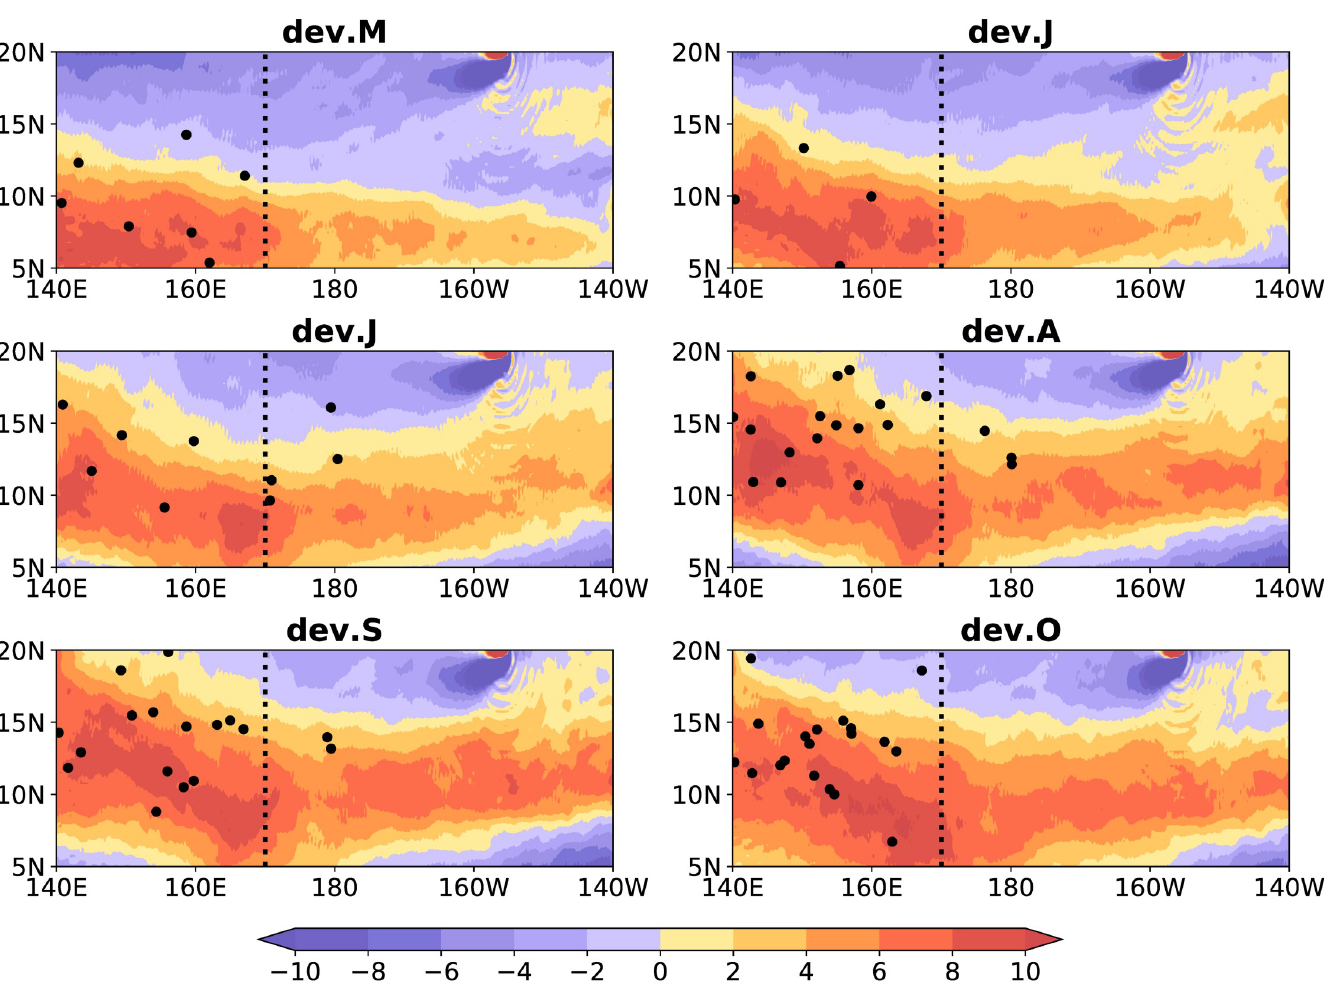
Fig 8. Location of monsoon trough and tropical cyclone. Shaded area indicates the composite monthly relative vorticity (10 − 6 s -1 ) at 850-hPa from May to October during eight El Ni ñ o developing years. The monsoon trough related to relative vorticity is the region between 140˚E–170˚E and with values greater than 0. The black dotted line represents 170˚E. The black dots indicate the locations of tropical cyclones. Title dev. M-O indicates the period from May to October during El Ni ñ o developing